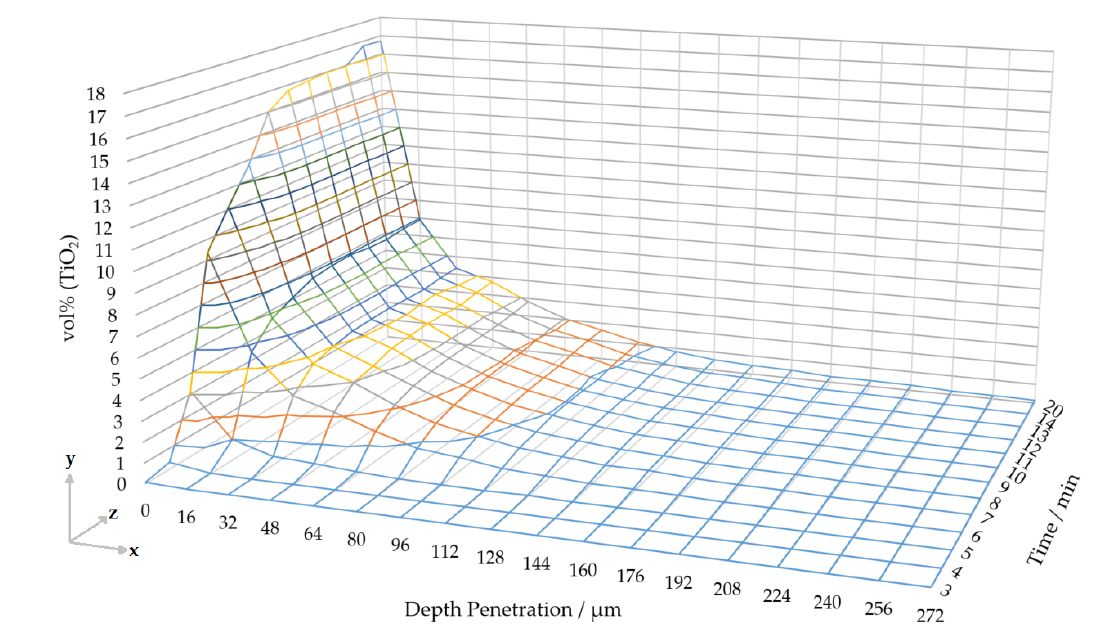
Figure 8. Concentration of TiO 2 deposits ( y -axis) against penetration depth ( x -axis) and time ( z -axis) for porosity in a representative volume during continuous filtration. The volume was divided into 16 µ m wide sub-volumes along the width of the filter wall and TiO 2 volumes calculated from within each of these sub-volumes in the time series, these are expressed as volume percentages in the